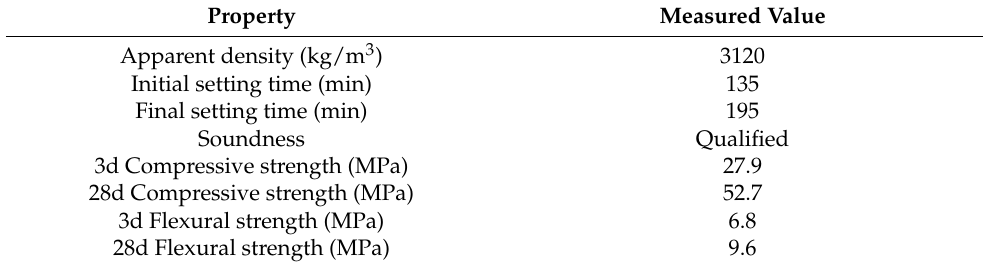
Table 1. Physical characteristics of cement.